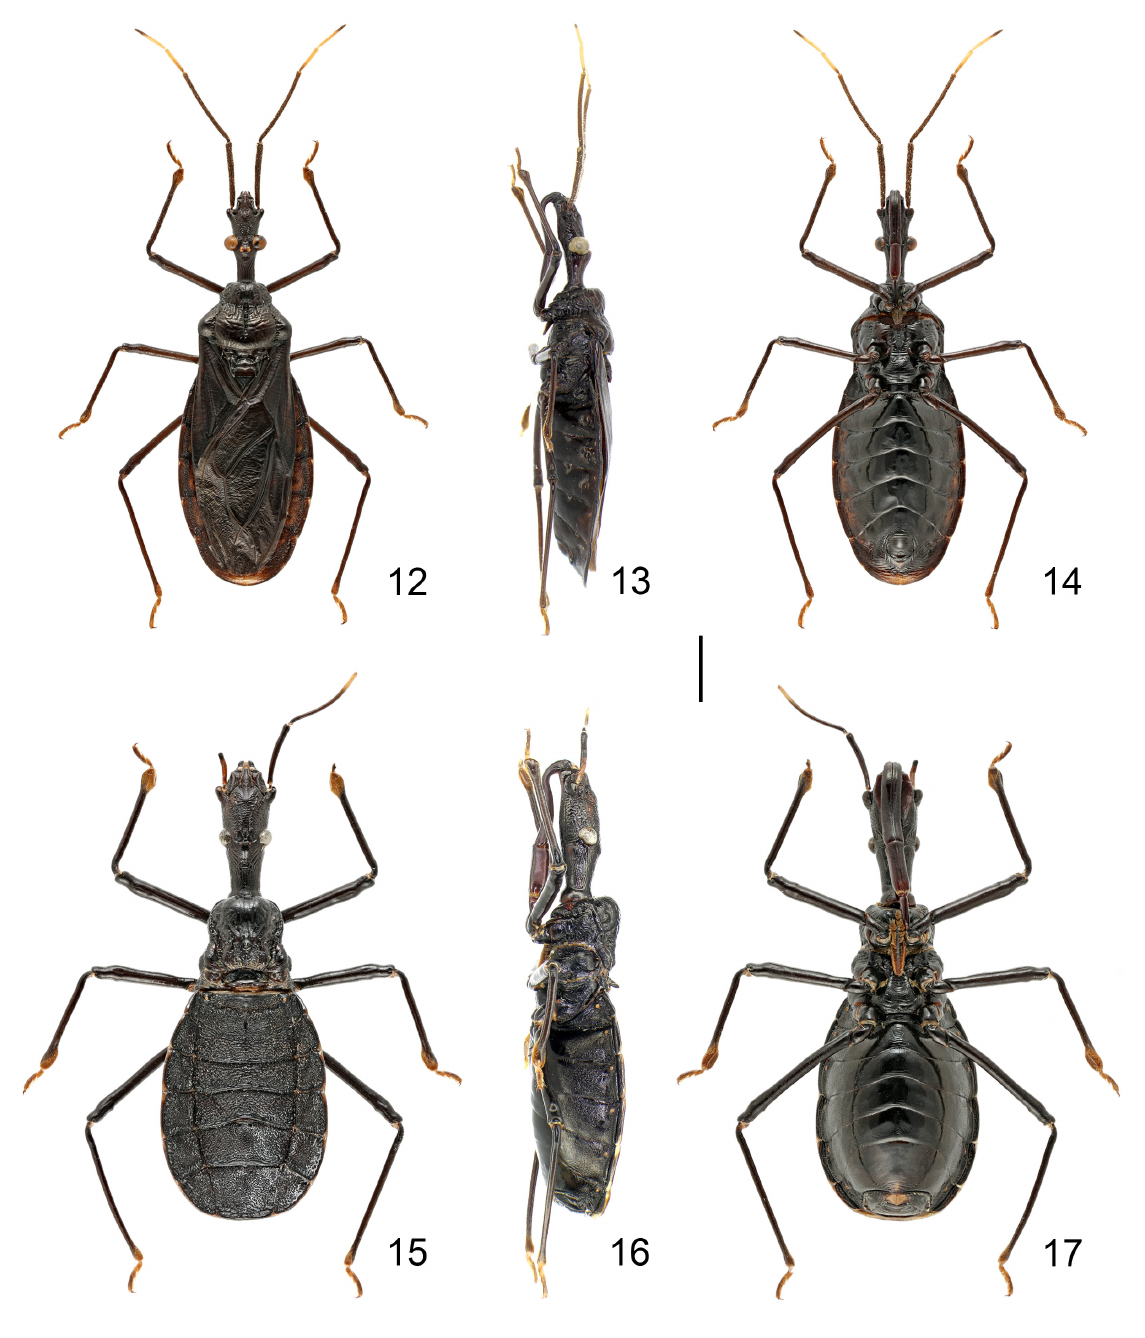
Figs 12–17. Xenorhyncocoris attractivus sp. nov., habitus. 12 . Paratype, ♂ (CAU-RE-0000005), dorsal view. 13 . Same, lateral view. 14 . Same, ventral view. 15 . Holotype, ♀ (CAU-RE-0000004), dorsal view. 16 . Same, lateral view. 17 . Same, ventral view. Scale bar = 5.00